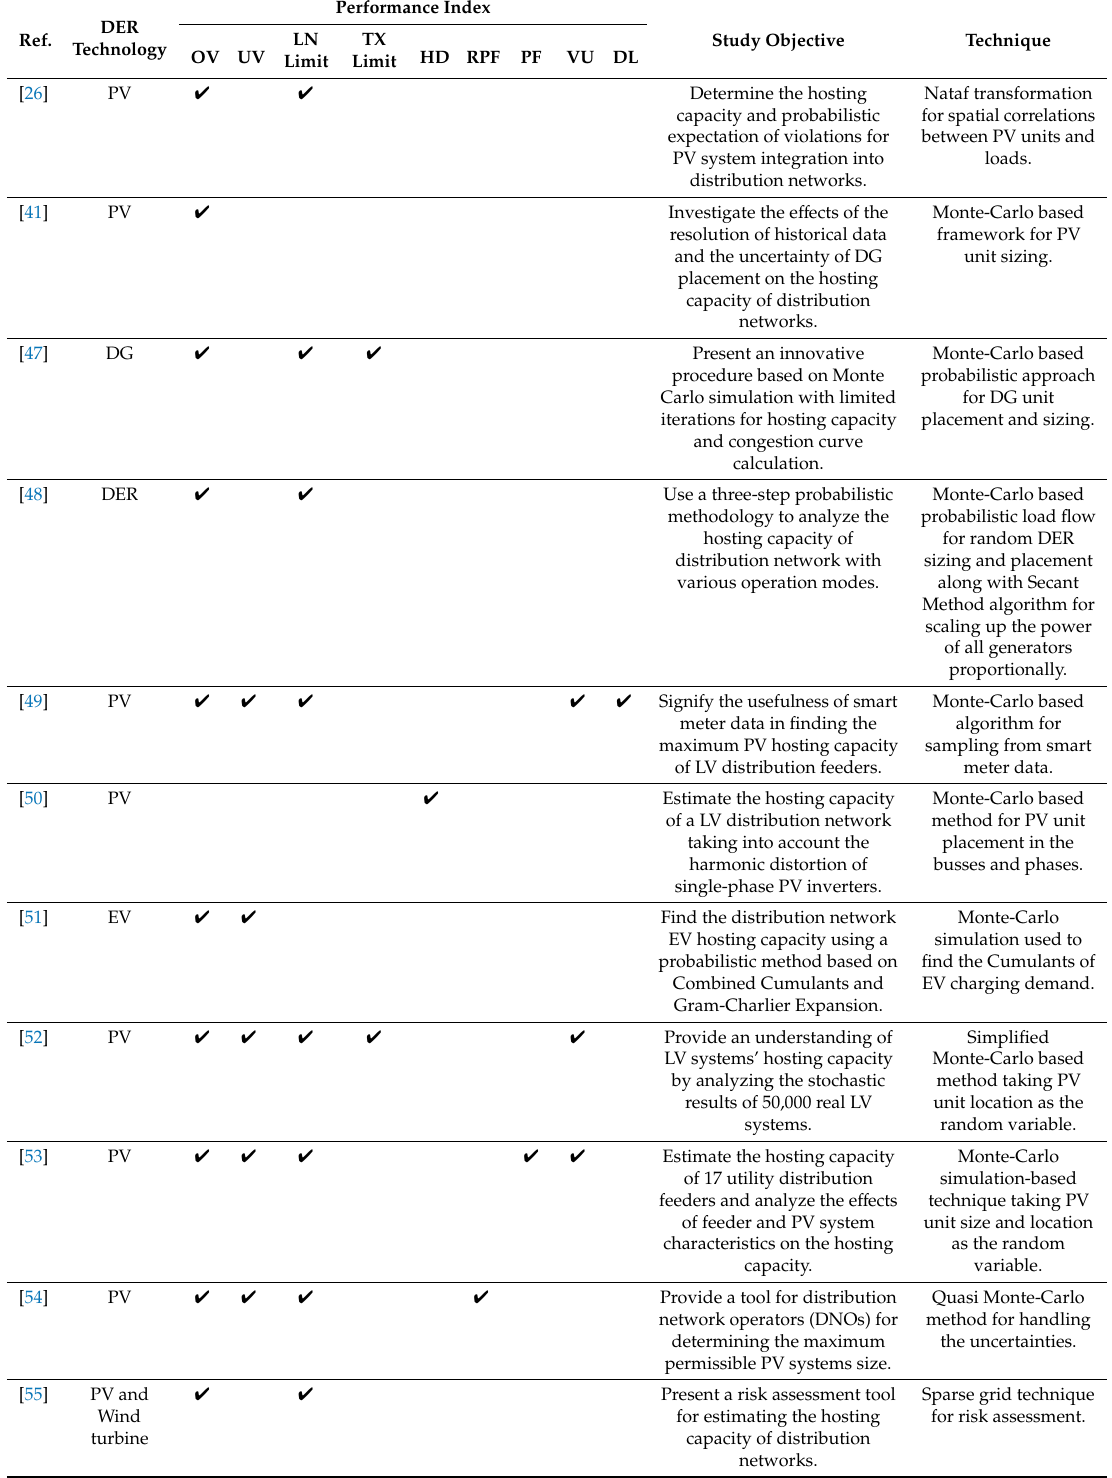
Simplified Monte-Carlo based